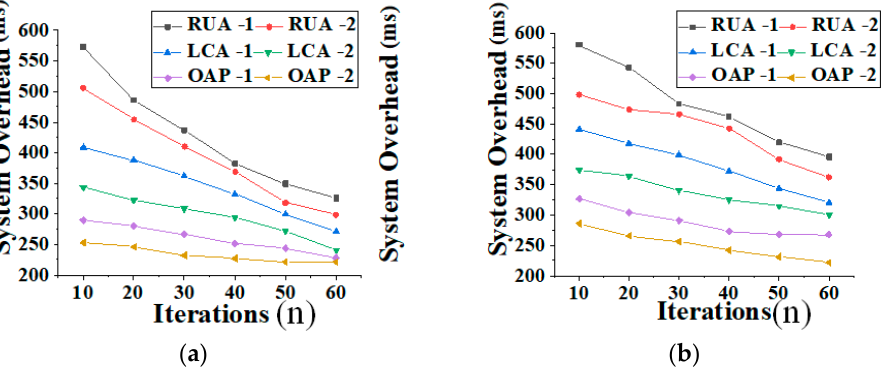
Figure 6. Variation curves of the system overhead with iteration: ( a ) variation curve under threshold = 0.1; ( b ) variation curve under threshold = 0.5.